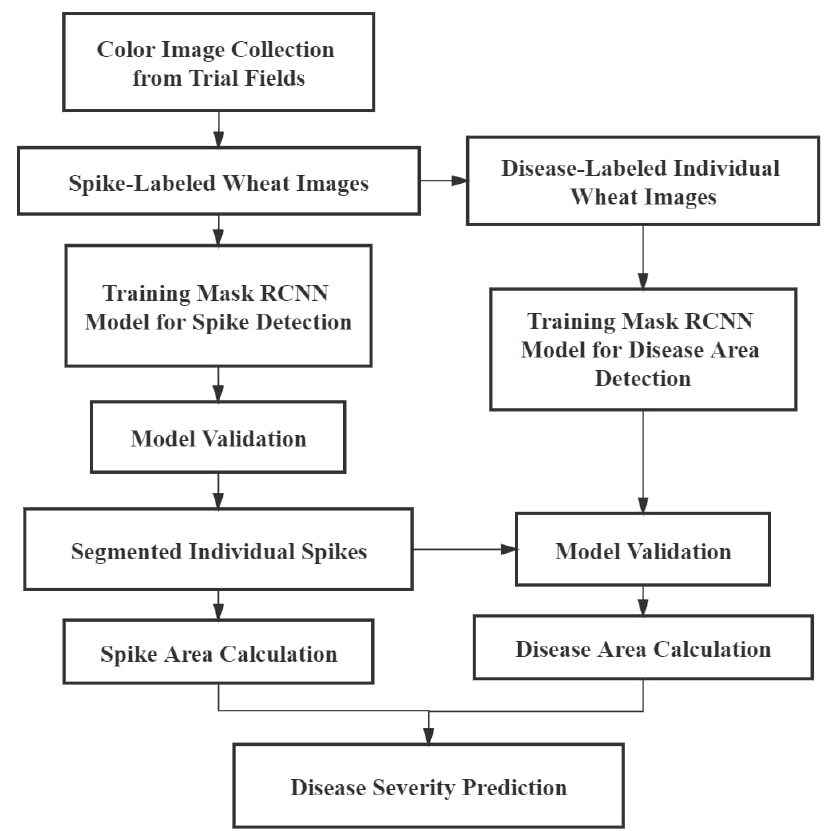
Figure 3. A flowchart of the proposed approach for evaluating FHB disease